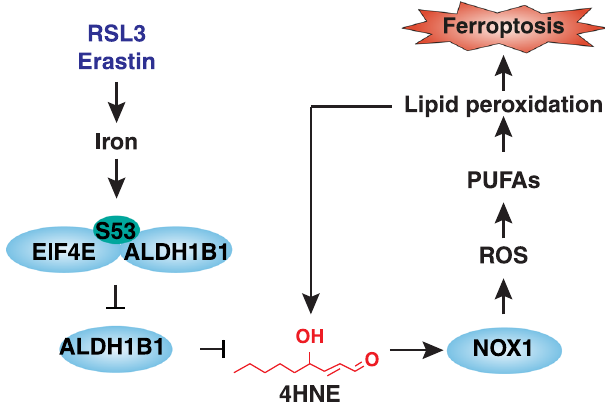
Fig. 7 | A model illustrating the function of EIF4E and ALDH1B1 in regulating 4HNE-mediated ferroptosis. EIF4E promotes ferroptosis by directly blocking ALDH1B1, thereby promoting the accumulation of toxic 4HNE and subsequent NOX1-dependent lipid